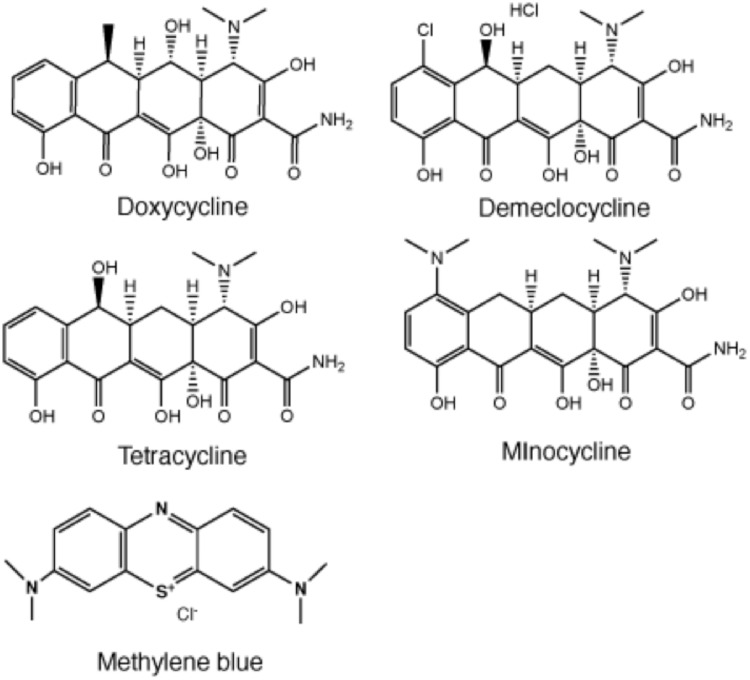
Chemical structures of tetracyclines together with methylene blue.